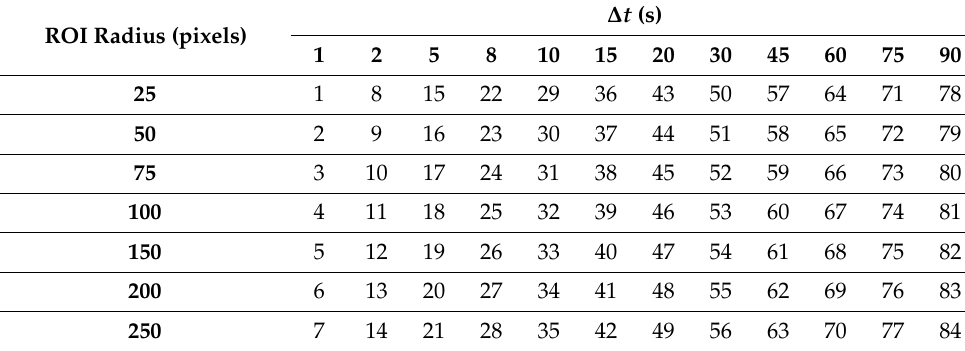
Table 4. Indexes used to identify the combinations of ∆ t and ROI radius. ROI Radius